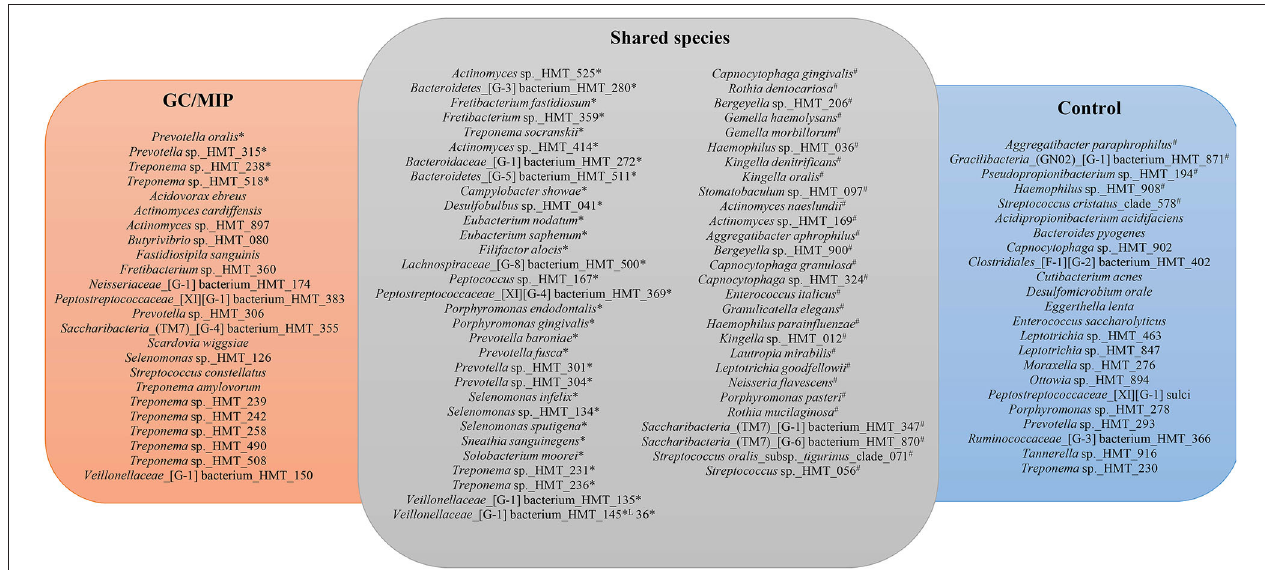
FIGURE 6 | Core microbiome based on species present in the oral biofilm of 50% of the individuals of GC/MIP, Control and shared species. Oral biofilm refers to the sum of reads of each taxon detected in all oral biofilm samples per group: (SpA + SbH + SbA) in GC/MIP and (SpH + SbH) in Control groups. *Species more abundant in GC/MIP. # Species more abundant in Control ( p < 0.05, Non-parametric t